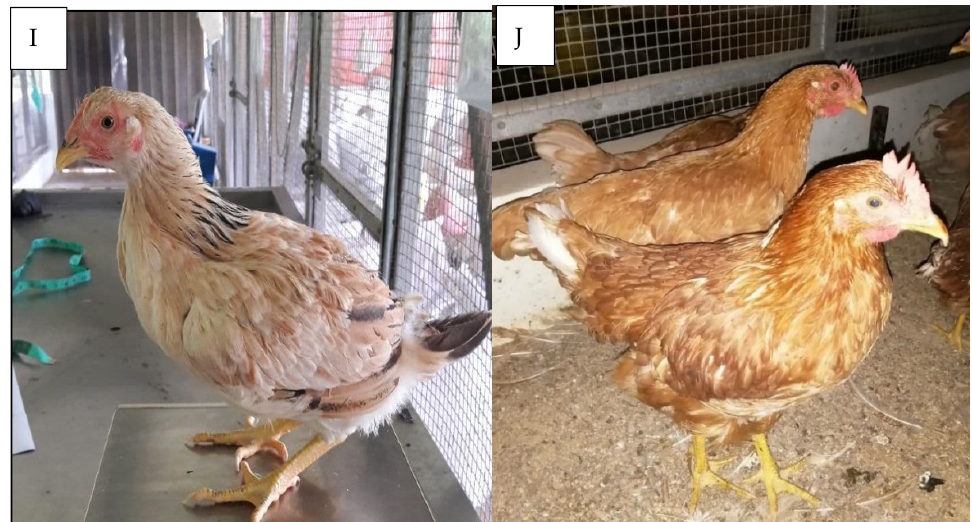
Figure 1. Appearance of 10 chicken types used in this study. ( A ) broiler-Cobb (Female), ( B ) broiler-Cobb (Male), ( C ) colored broiler-Hubbard (Female), ( D ) colored broiler-Hubbard (Male), ( E ) naturally mated village chicken (Ayam Kampung) (Female), ( F ) naturally mated village chicken (Ayam Kampung) (Male), ( G ) underaged colored broiler-Sasso (Female), ( H ) underaged colored broiler-Hubbard (Female), ( I ) selective bred village chicken (Akar Putra) (Female), and ( J ) layer-DeKalb (Female).